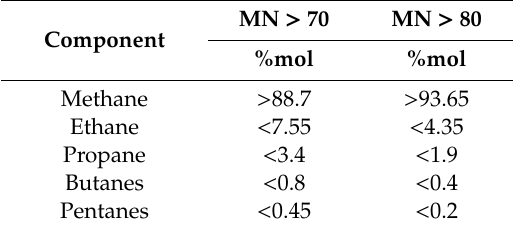
Table 8. Proposed compromise limit contents of LNG components for various methane number